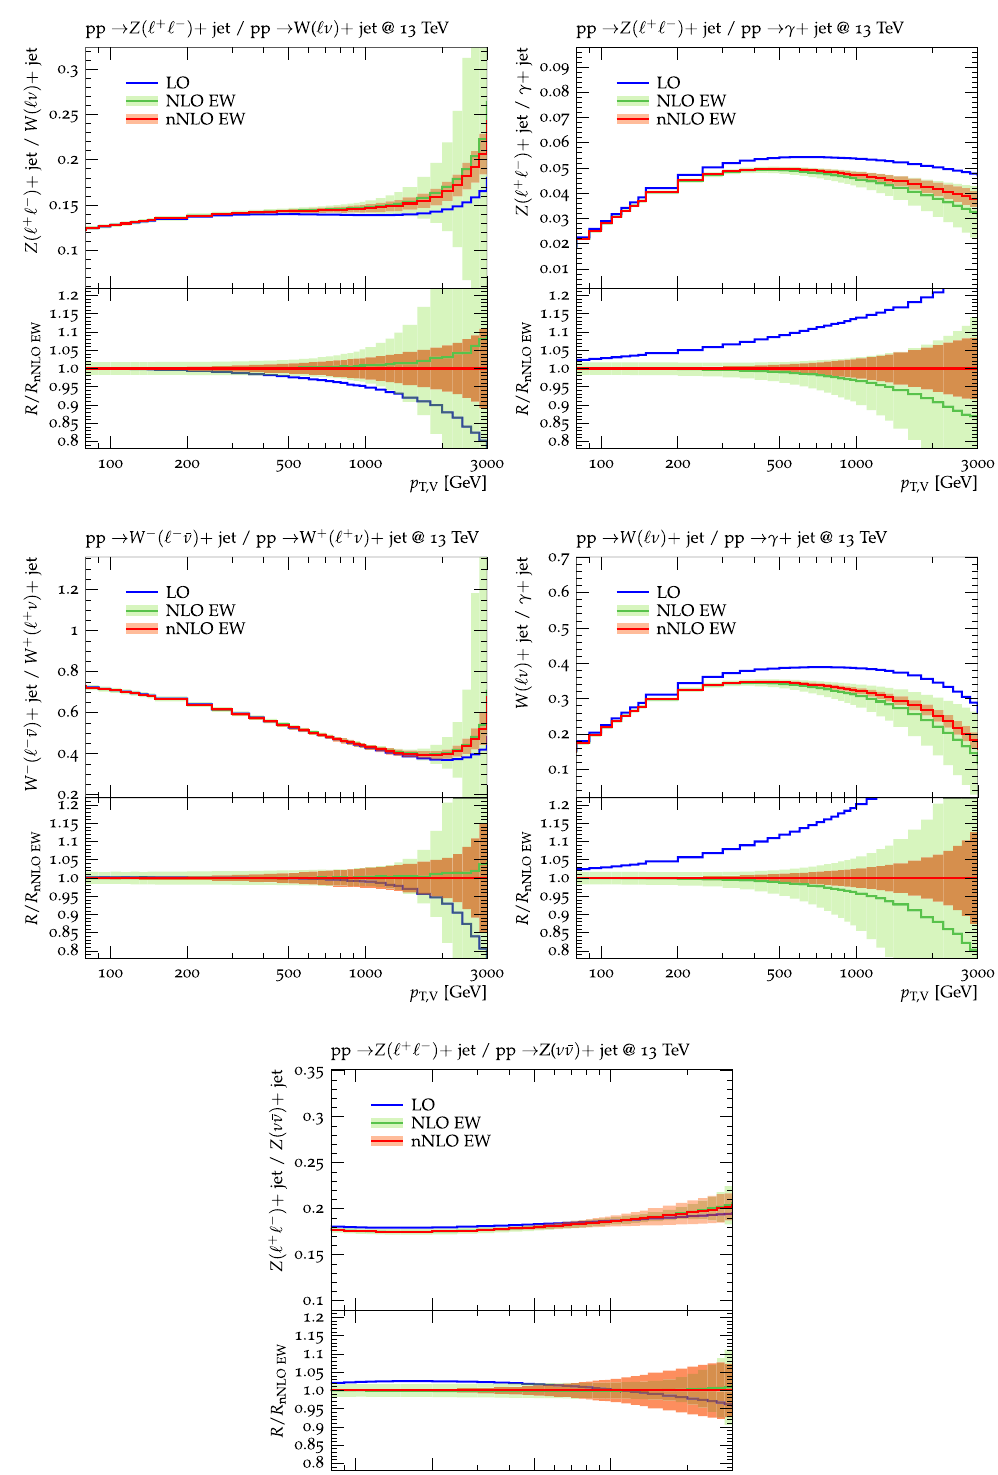
( V ) is EW ( V ) ( V ) and δ ( 3 ) κ EW EW